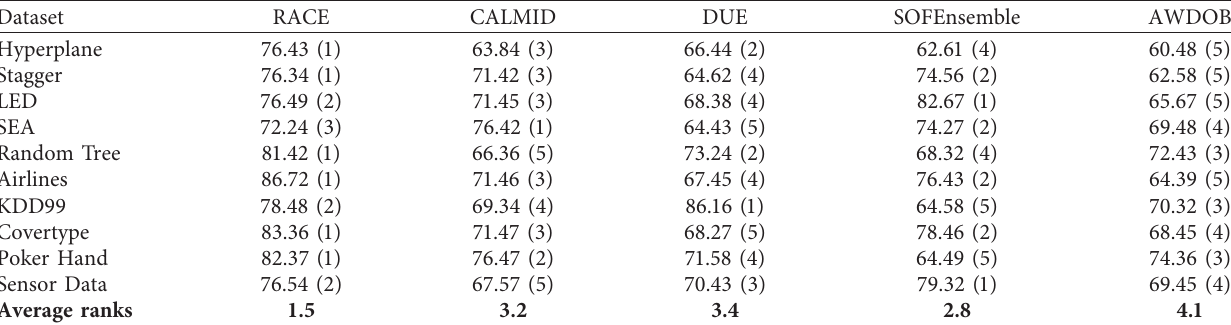
Table 3: Kappa temporal values for all the ten datasets.